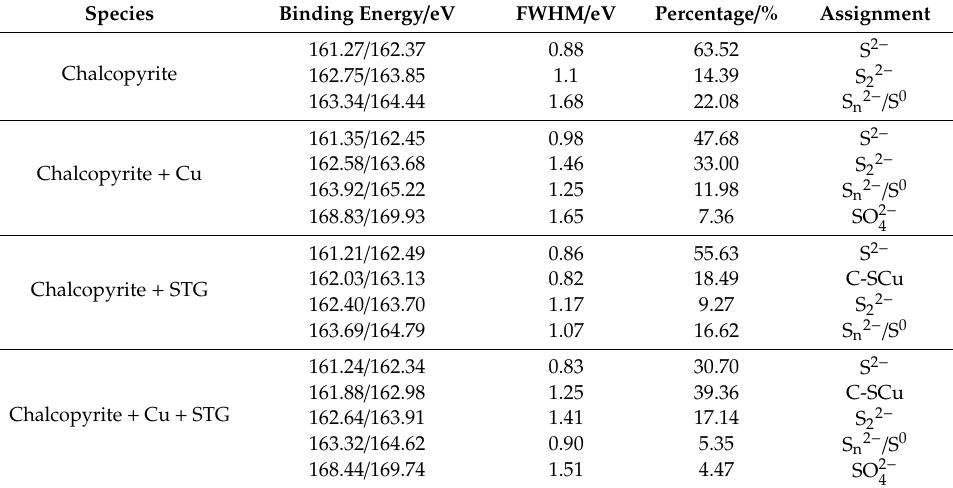
Table 2. The parameters and assignment of high-resolution S 2p XPS